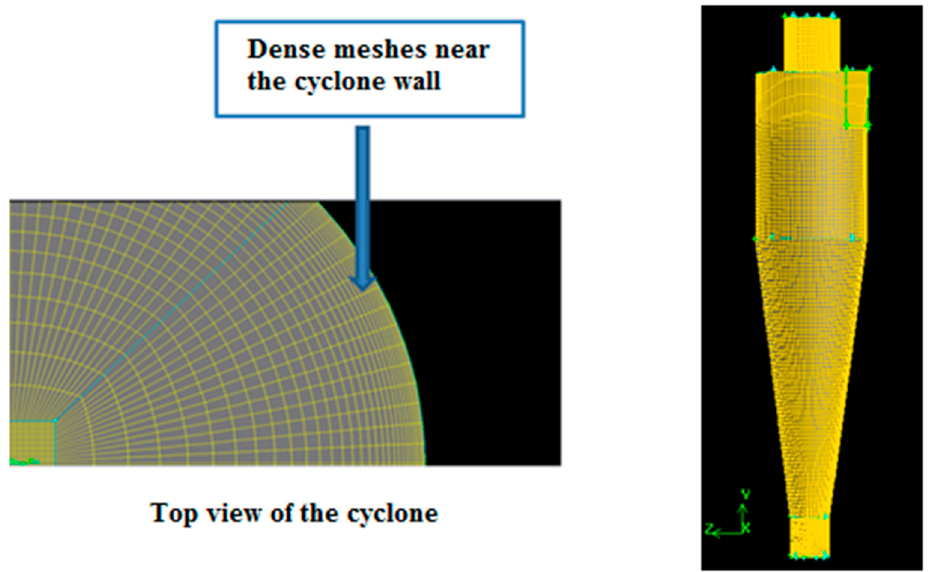
Figure 3. Meshing of cyclone in gambit.